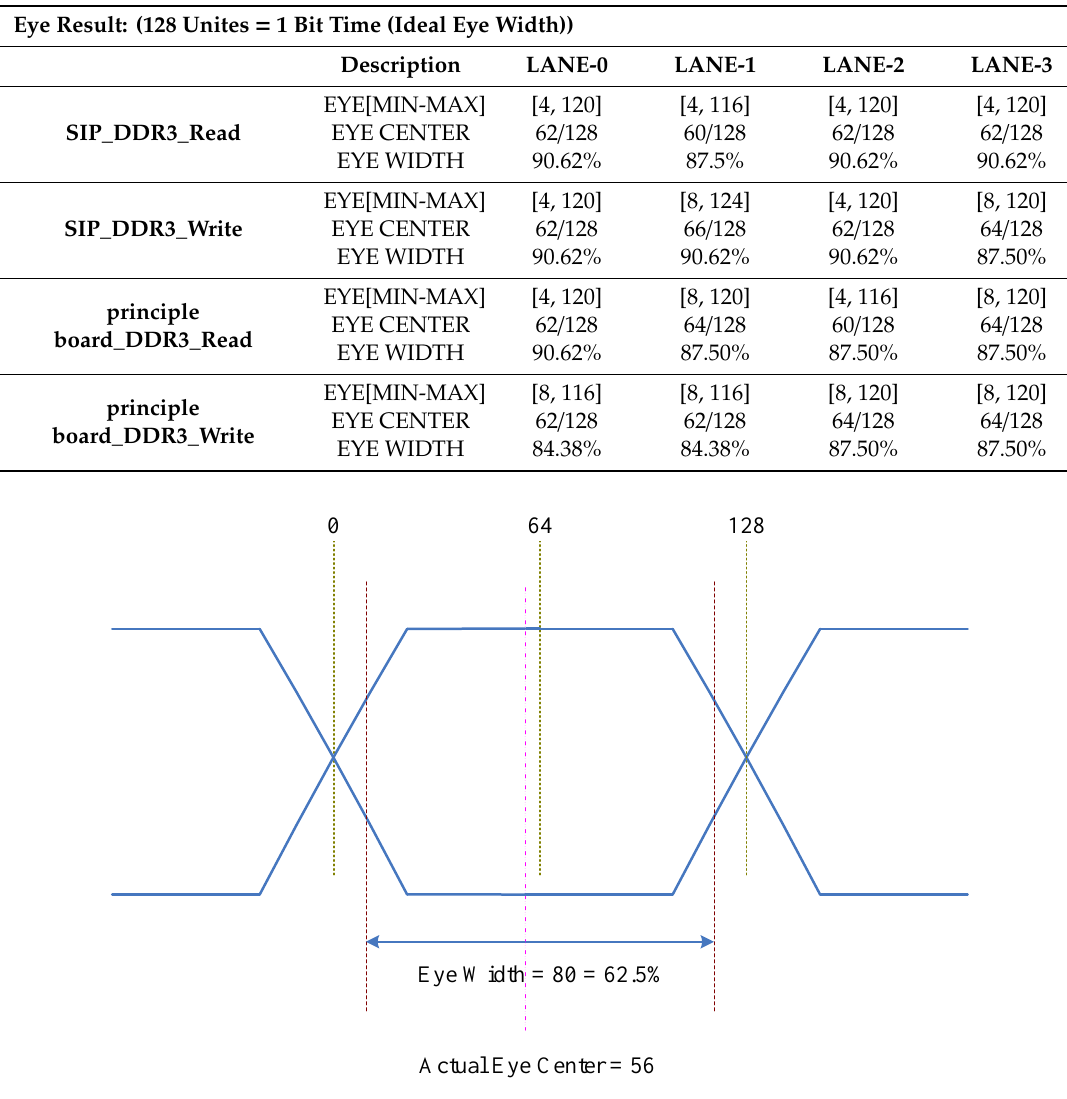
Figure 10. Eye diagram test schematic.